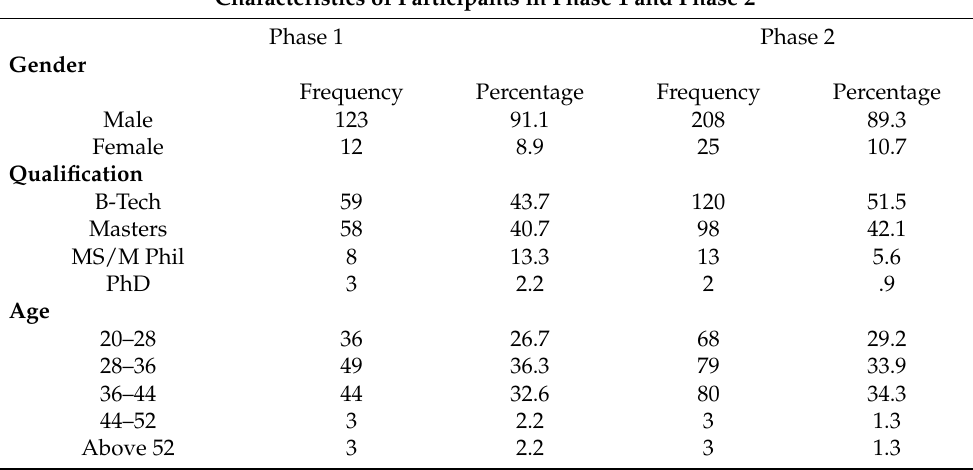
Table 2. Characteristics of the